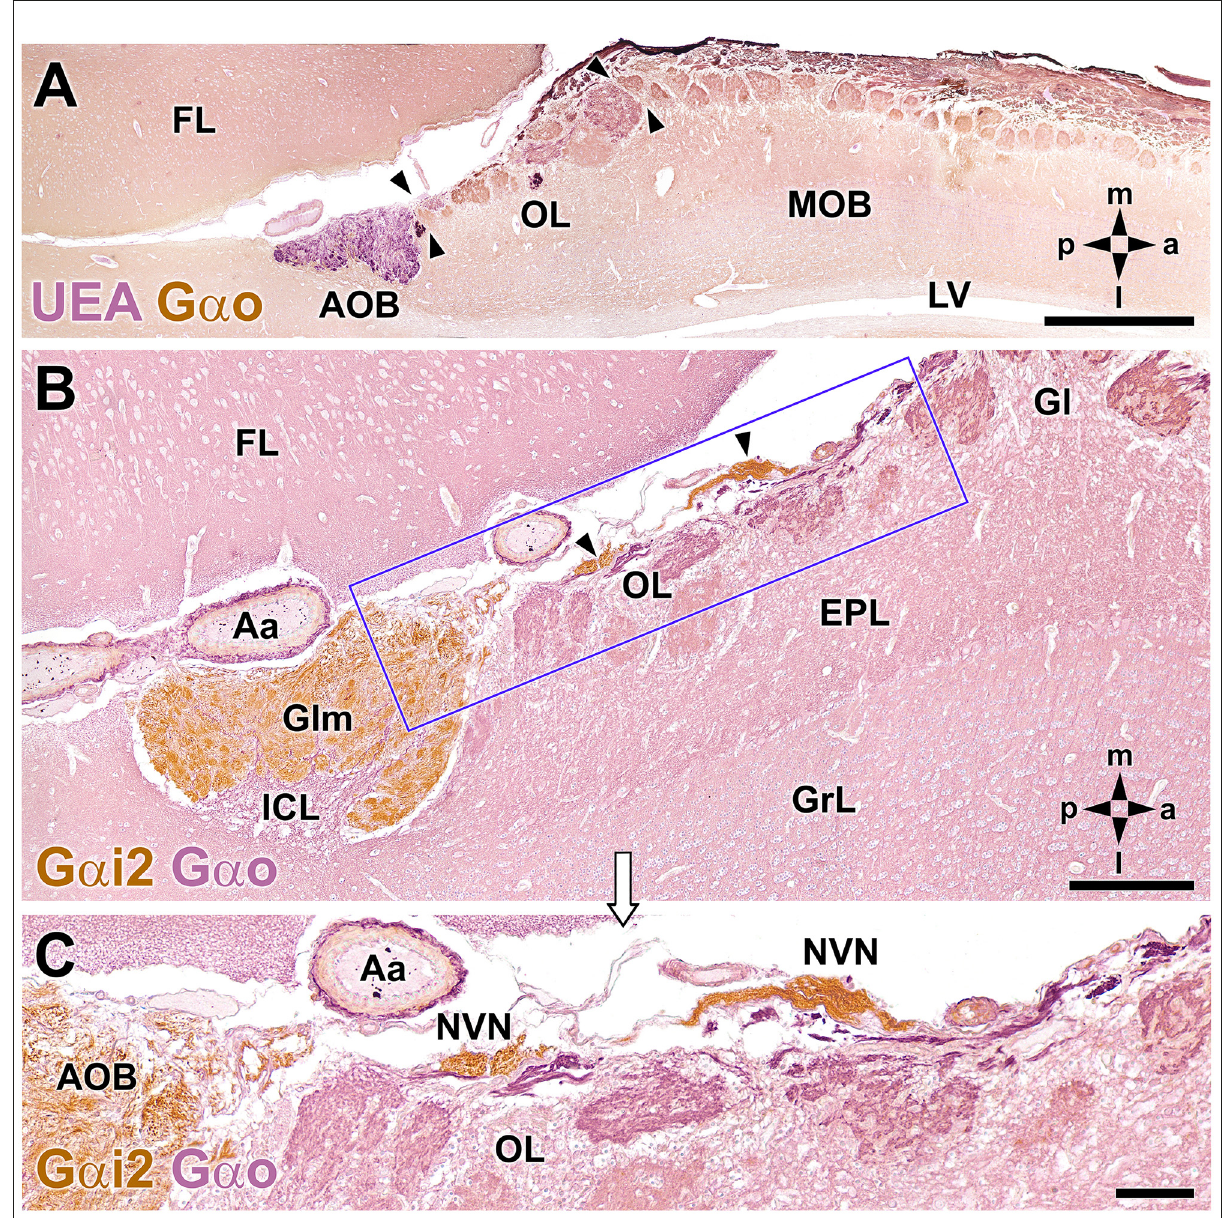
FIGURE2 Double-immunohistochemical labeling of the fox olfactory limbus (OL). (A) Double immunostaining with Ulex europaeus agglutinin (UEA) lectin (magenta) and G α o antibody (brown). The vomeronasal nerve and glomerular layers of the accessory olfactory bulb (AOB) are strongly labeled with UEA. Anti-G α o immunolabeling shows a widespread immunopositive pattern, more intensely in both the olfactory nerve and glomerular layers of the MOB. The OL, delimited by arrowheads, comprises irregularly shaped glomeruli, without a homogeneous immunostaining pattern. (B,C) Double immunostaining for G α i2 (brown) and G α o (magenta). Anti-G α i2 stains the superficial AOB and the nervus vomeronasalis (NVN, arrowheads). Anti-G α o stains the internal cellular layer (ICL) of the AOB and the neuropil of the olfactory bulb. The box in (B) is enlarged in (C) , showing that the OL comprises irregularly shaped glomeruli without a homogeneous immunostaining pattern. The branches of the NVN, which are G α i2-immunopositive, contrast with the G α o-immunopositive nerve endings that project to the OL glomeruli. Aa, artery; EPL, external plexiform layer; FL, frontal lobe; Gl, MOB glomerular layer; Glm, AOB glomerular layer; GrL, MOB granular cell layer; LV, lateral ventricle. The compass indicates the orientation, as follows: m, medial; l, lateral; p, posterior; a, anterior. Scale bars: (A) : 1 cm. (B,C) : 250 µ m.